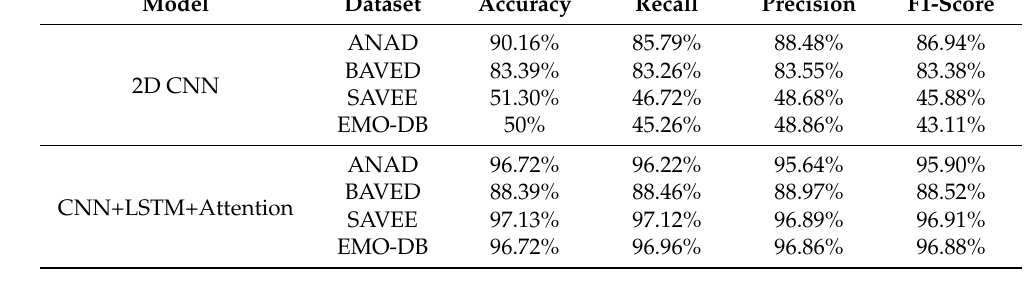
Figure 8. Loss and accuracy plots for the ( a ) ANAD, ( b ) BAVED, ( c ) SAVEE, and ( d ) EMO-DB da- tasets for the 2D CNN model.